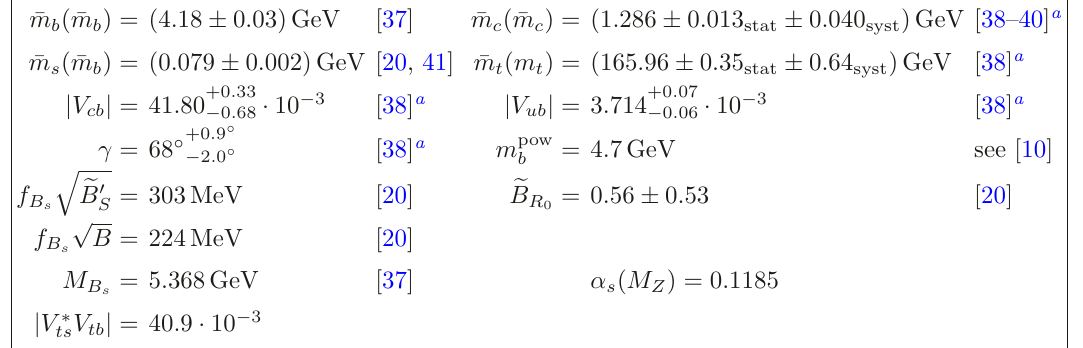
s ( ¯ m b ) is calculated from ¯ m s (2GeV) = 0 . 094 ±